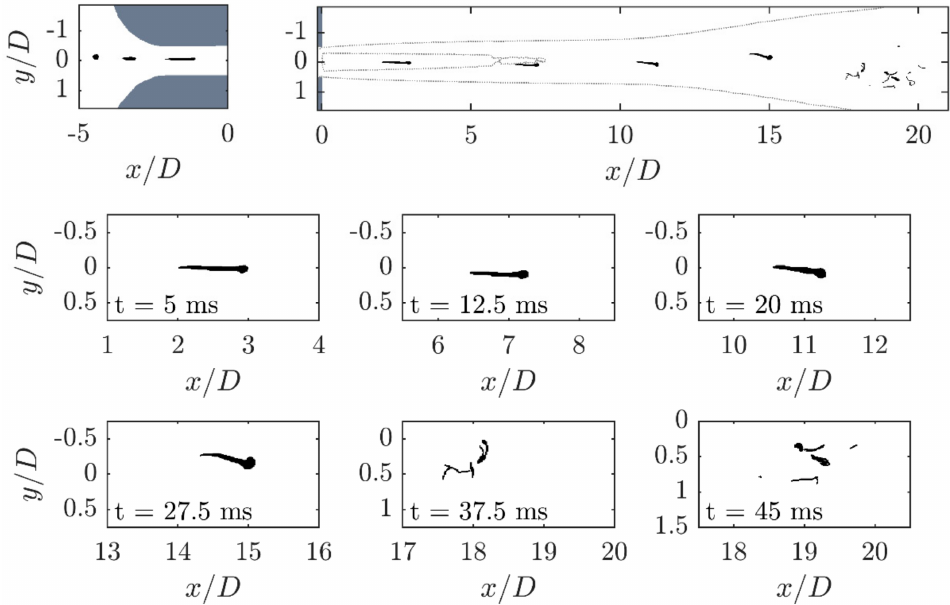
Figure 24. Development of droplet break-up at a low viscosity ratio ( λ = 0.3) at Re = 2000.